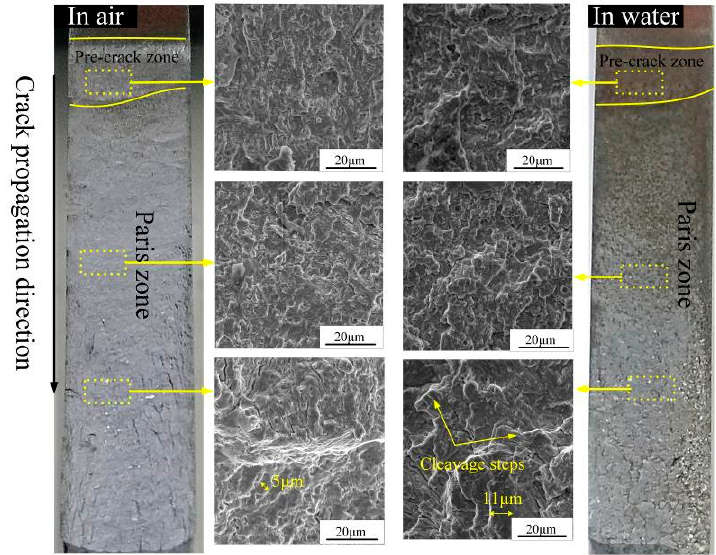
Figure 8. Fracture morphology of fatigue crack growth specimens. The left is loading in the air and the right is loading in the water condition.